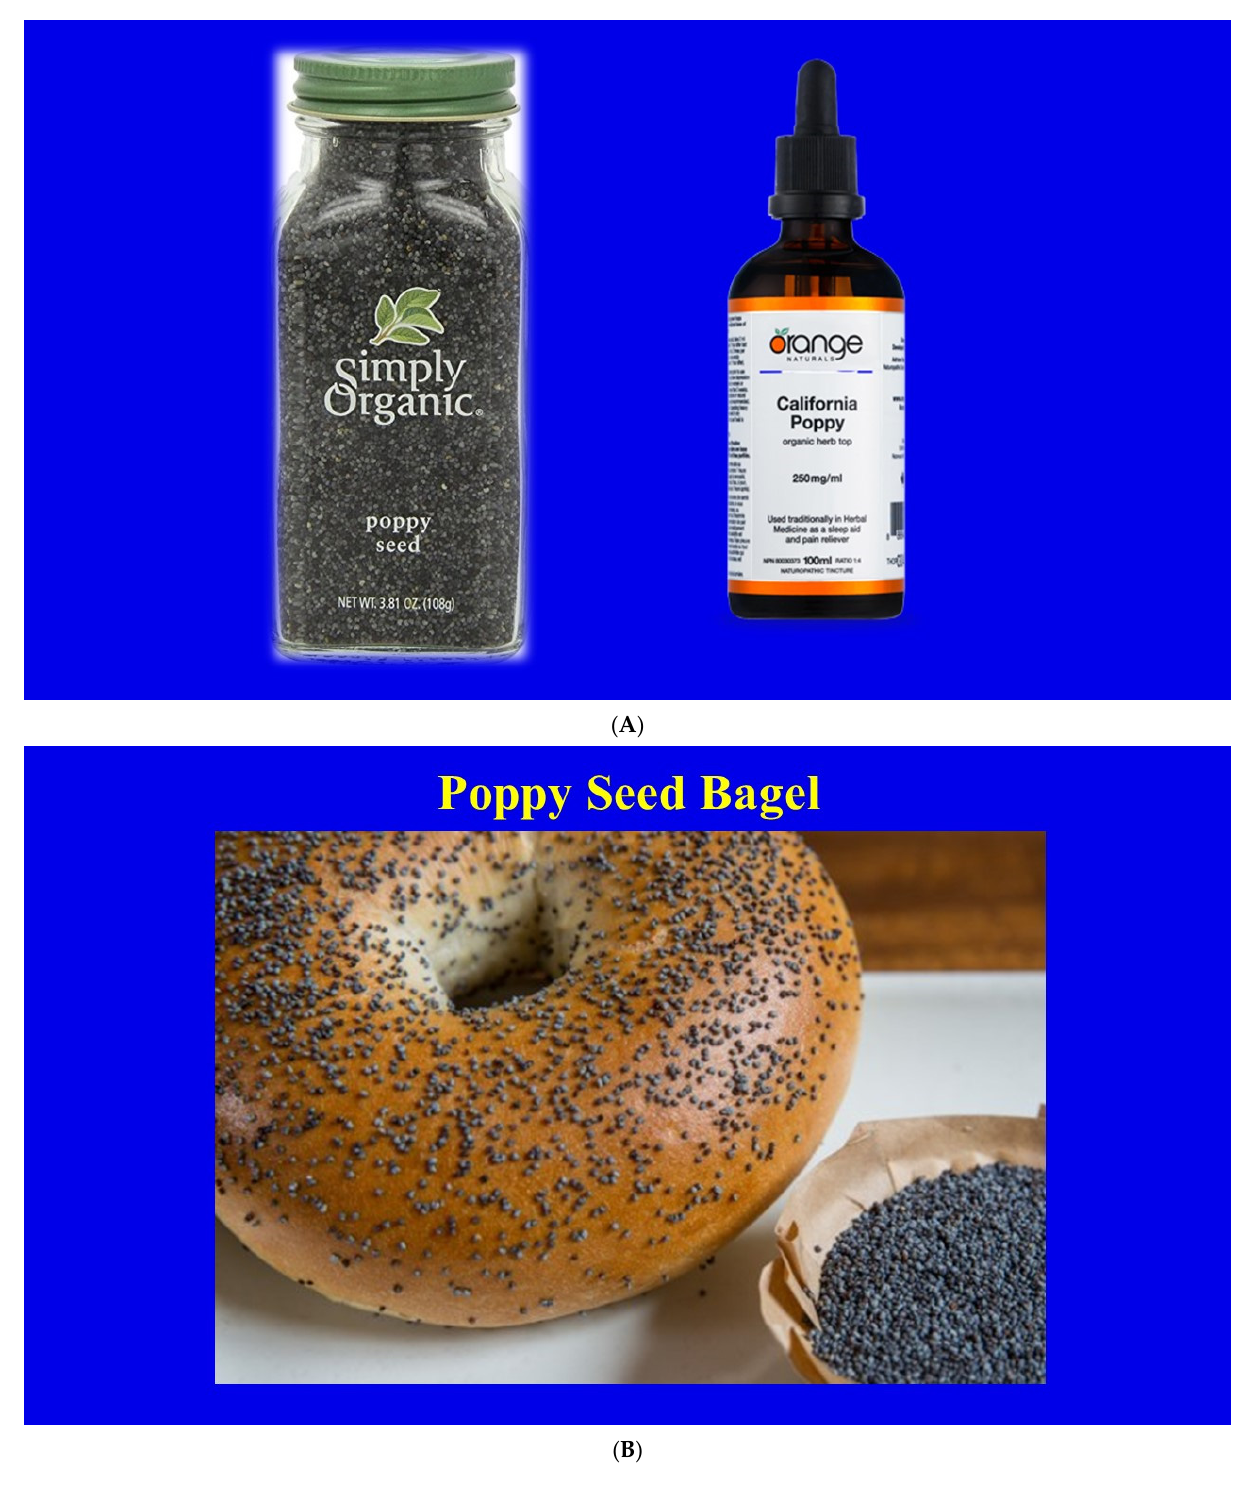
Figure 3. ( A ) Poppy seeds for baking and herbal use. Photographs are public domain. ( B ) Poppy seed bagel. Photograph Figure 3. California poppy seeds have a culinary function and may be used as supplement ( A ) California poppy seeds for is public domain. baking and herbal use. Photographs are public domain. ( B ) California poppy seed bagel. Photograph is public